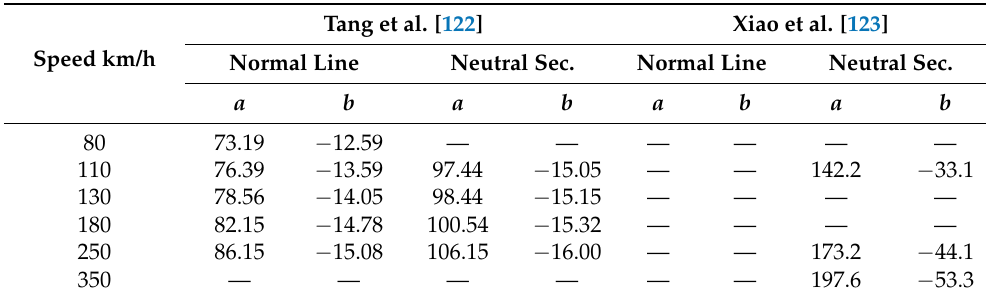
Table 2. Parameters a and b of (49) expressed in dBµV/m of the electric field equation in the 100MHz to 350MHz frequency interval for plain line and neutral section measurements [122,123]. Tang et al. [122] Xiao et al. [123] Speed km/h Normal Line Neutral Sec. Normal Line Neutral Sec. a b a b a b a b 80 73.19 142.2 78.56 98.44 − 15.15 180 82.15 350 197.6 −